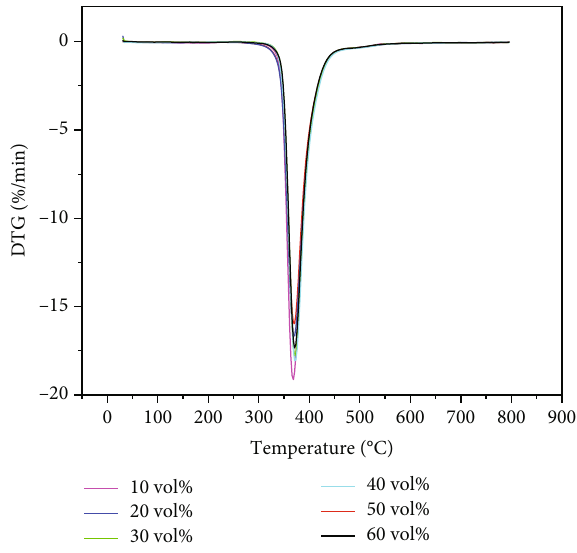
Figure 8: DTG curves of the HGM/EP composite insulation materials. The peak thermal decomposition temperatures for the HGM/EP composite insulation materials with HGM volume fractions of 10 vol%, 20 vol%, 30 vol%, 40vol%, 50vol%, and 60vol% were 368.0 ° C, 369.8 ° C, 371.9 ° C, 371.4 ° C, 369.7 ° C, and 371.1 ° C, respectively.